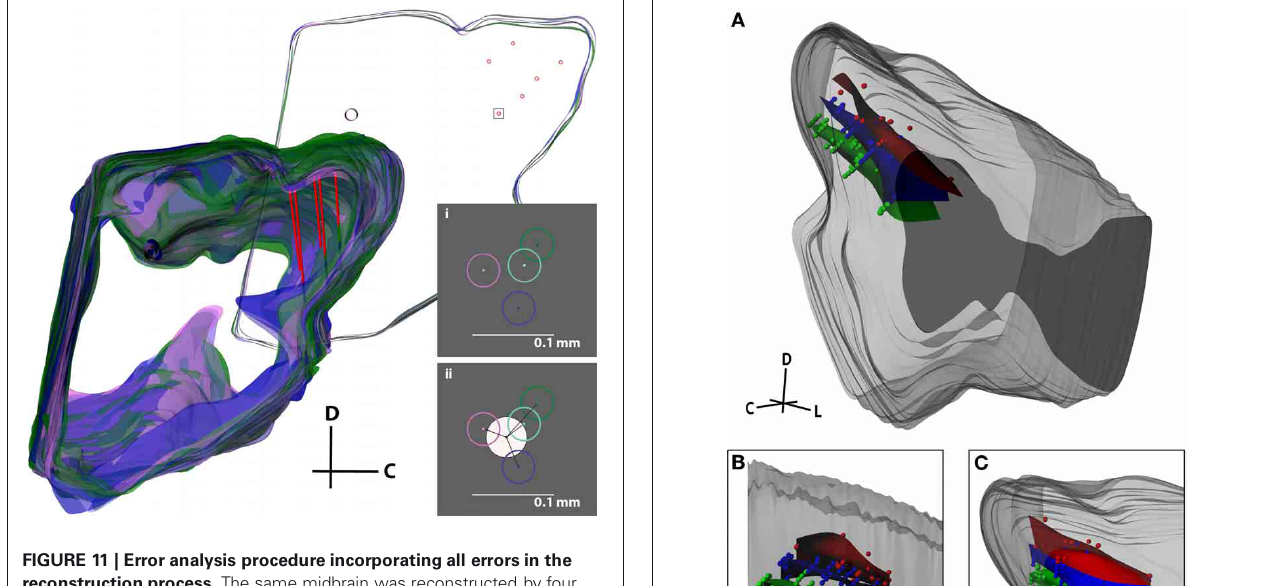
FIGURE 11 | Error analysis procedure incorporating all errors in the reconstruction process. The same midbrain was reconstructed by four different individuals (purple, pink, cyan, and green), aligned, and normalized to each other. The consistent reference track for each midbrain and three pairs of electrode tracks from one of the four midbrains (red) are displayed. A single slice was removed for analysis (top right), and a box around one electrode placement is shown in inserts (i) and (ii) . The error was either calculated ( i ) by taking the distance between each of the four electrode track points (center-to-center of the circles), or (ii) by finding the average of the four placements (white circle) and calculating the distance from its center to each electrode track point. The distances for each of the six electrode points across five slices were averaged to obtain the total error for this analysis. C, caudal; D, dorsal.